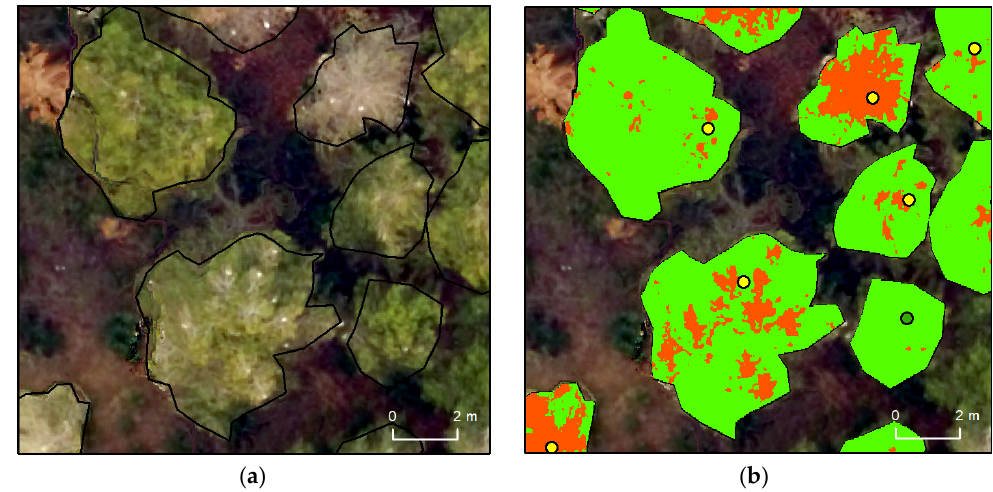
Figure 4. Pine processionary moth defoliation in healthy (green dots) and infested trees (yellow dots) in Torregassa forest. ( a ) Manual crown segmentation on the orthomosaic; ( b ) Defoliation measured as infested (red) or non-infested (green) using RGB-UAS images and the automatic classification.